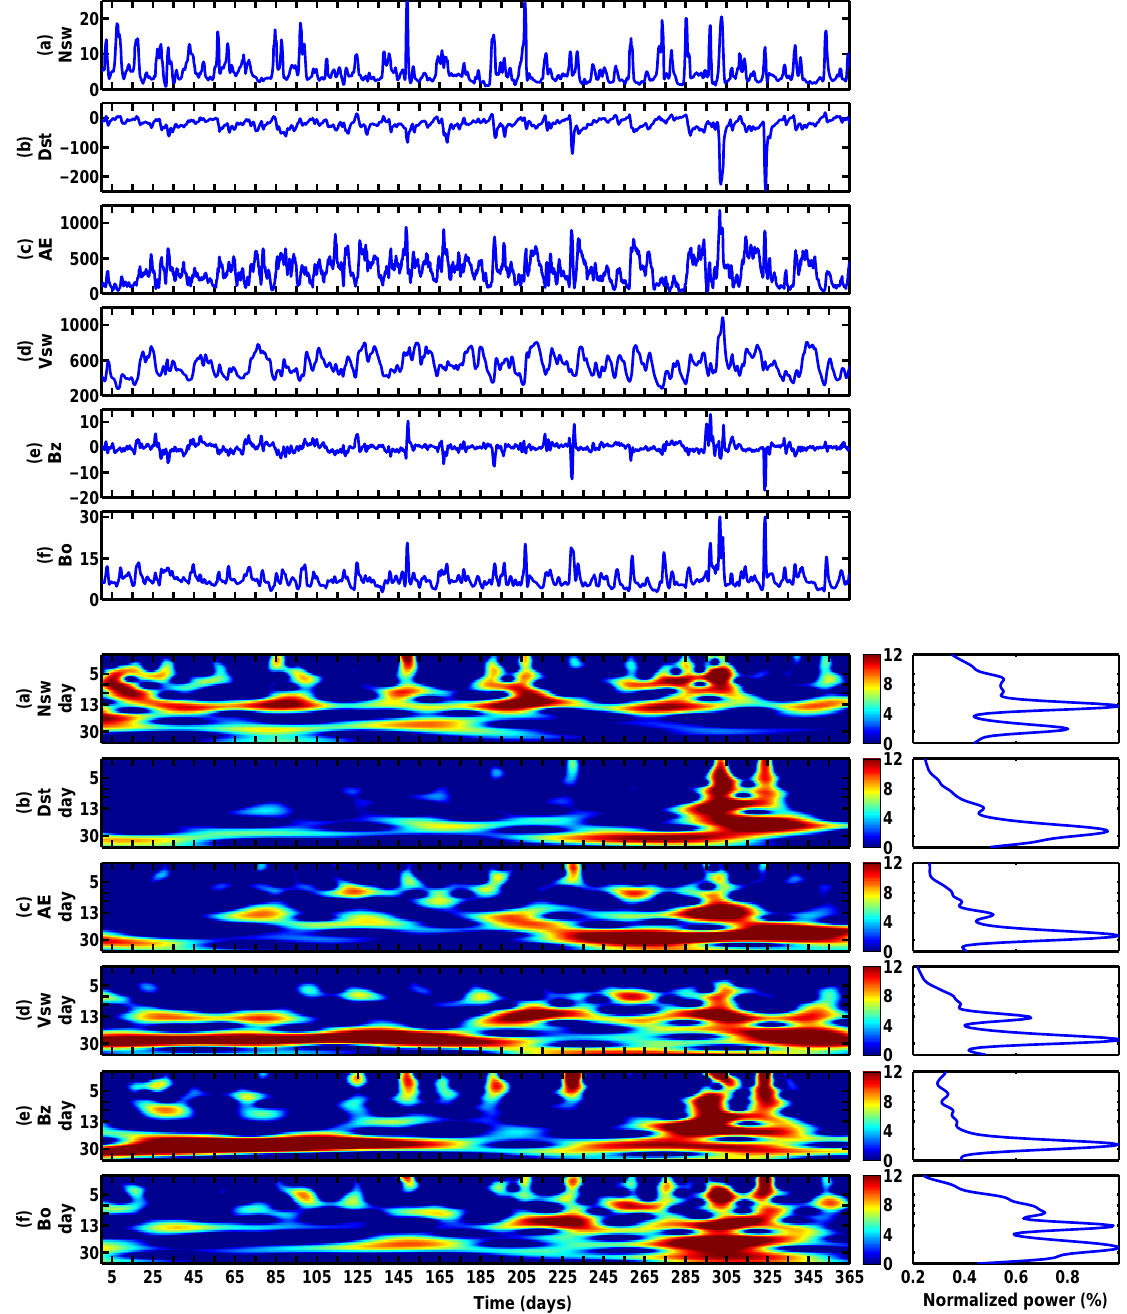
Figure 1. From top to bottom, the upper panel shows the time series and the bottom panel shows wavelet scalogram and global normalized wavelet spectrum of (a) plasma density ( N sw in cm − 3 ), (b) Dst (nT), (c) AE (nT), (d) solar wind speed ( V sw in kms − 1 ), (e) B z (nT) component of IMF (GSM coordinates) and (f) IMF magnitude ( B o in